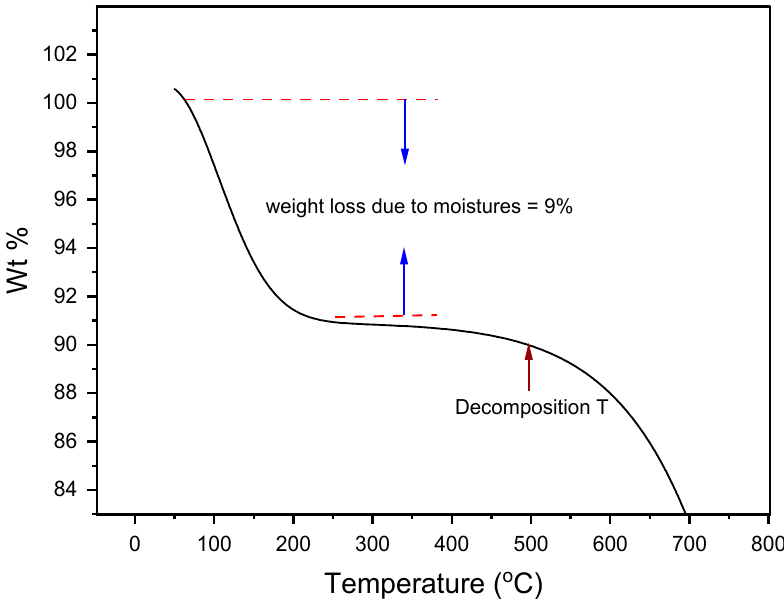
Figure 7. Decomposition profile of chosen salt composition (32 mol% LiCl-68 mol% LiOH).